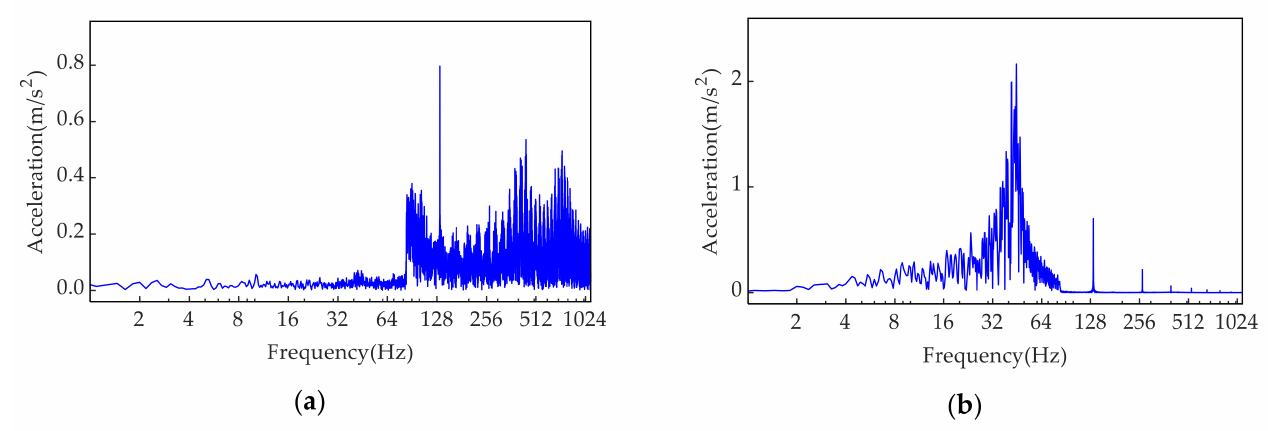
Figure 16. Frequency distribution of the vertical acceleration of wheel-sets under: ( a ) track short wave irregularity; ( b ) track medium-long wave